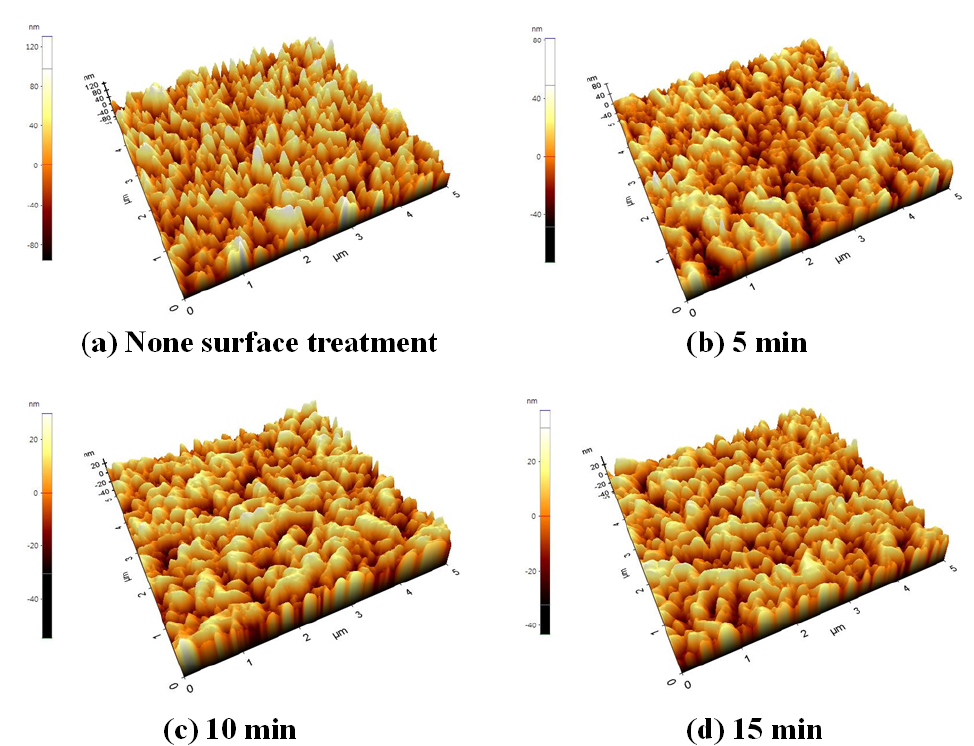
Figure 7. Surface morphology of the FTO substrate with and without the CMP process. ( a ) None surface treatment, ( b ) 5 min, ( c ) 10 min, ( d ) 15min. Table 1. Surface roughness parameters of the surface-treated FTO substrate. Treatment Time Ra (nm) RMS